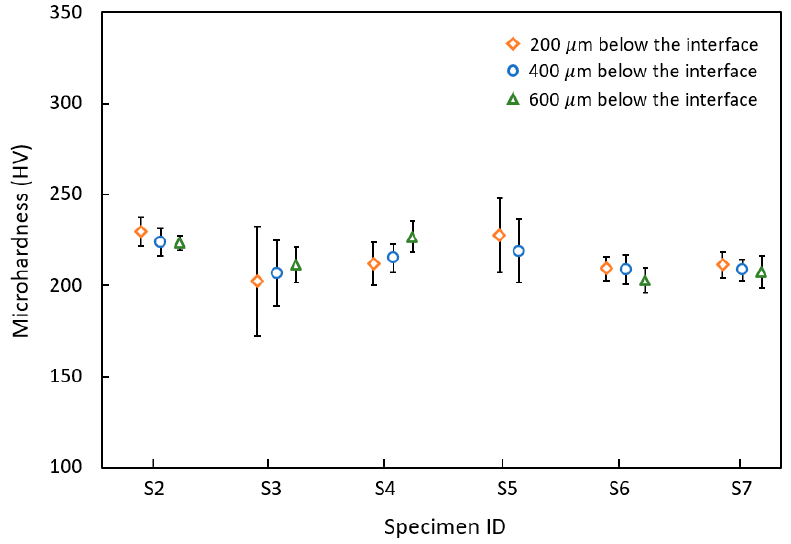
Figure 4. Microhardness at different depth locations of the specimens’ substrates.